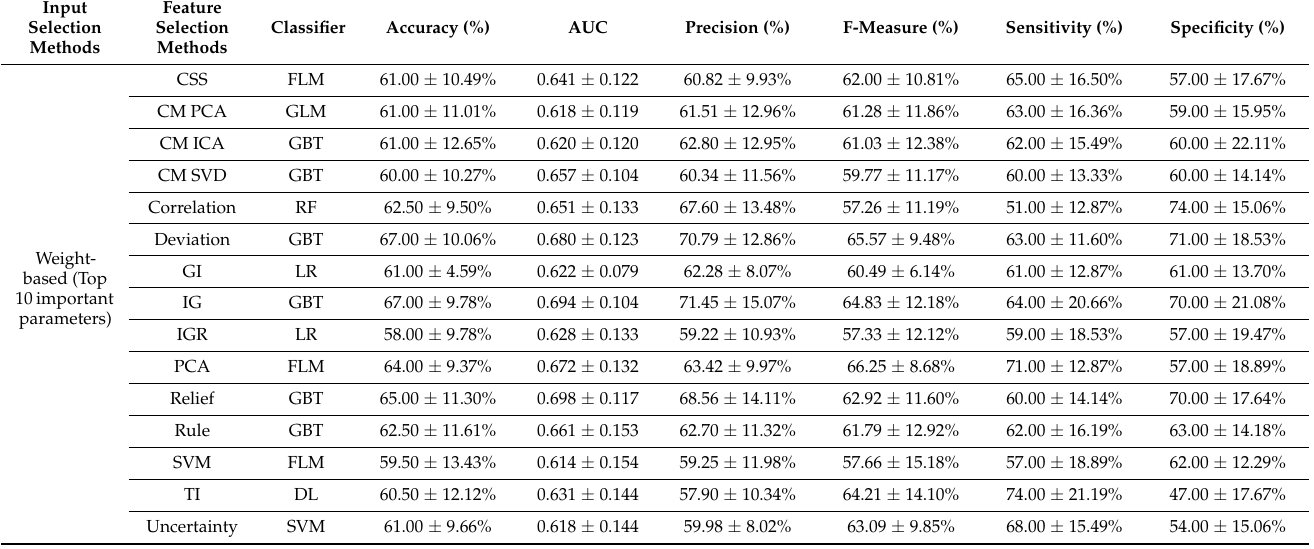
Table 2. Performance matrix of the machine learning